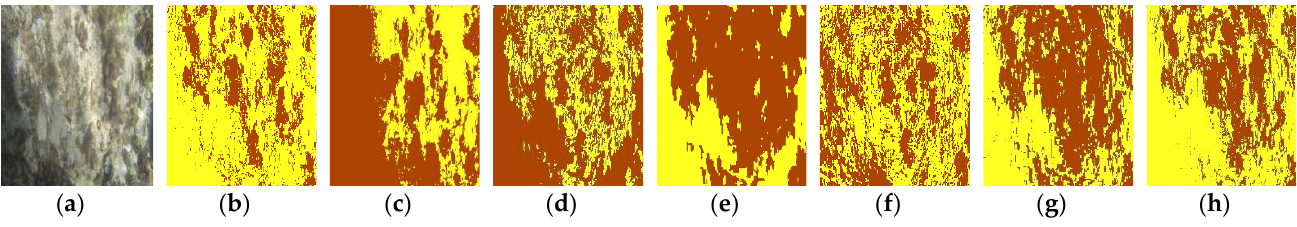
Figure 12. Validation tests of the proposed segmentation algorithms using highly illuminated and low contrast brown algae image (19) from Figure 9 as example of three categories: ( a ) original image; ( b ) ground truth image; ( c ) FF result; ( d ) FR result; ( e ) OS result; ( f ) KM result. Brown: brown algae, green: algae, and yellow: sediments.